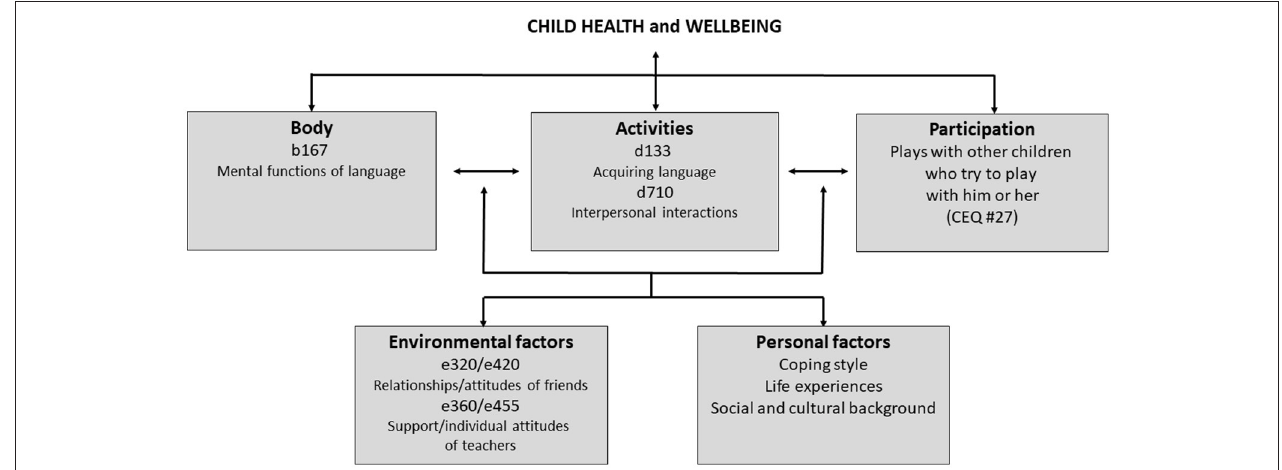
FIGURE 4 | Tentative interactive relationship between the ICF-CY dimensions related to CEQ